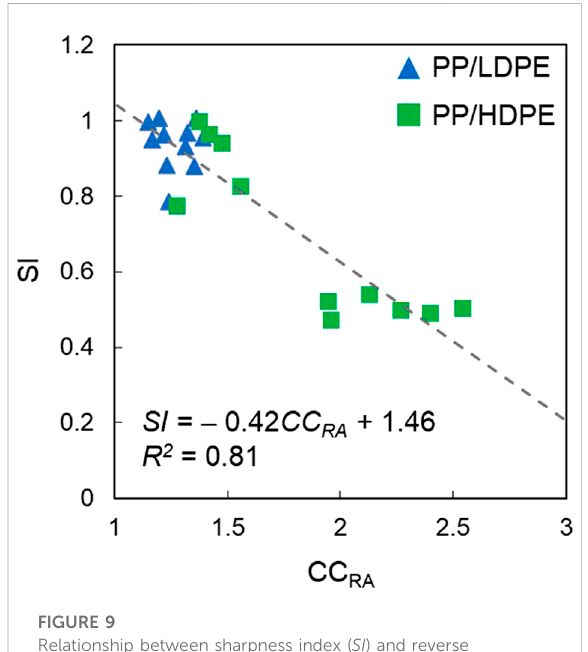
FIGURE 9 Relationship between sharpness index ( SI ) and reverse apparent concentration criterion ( CC RA